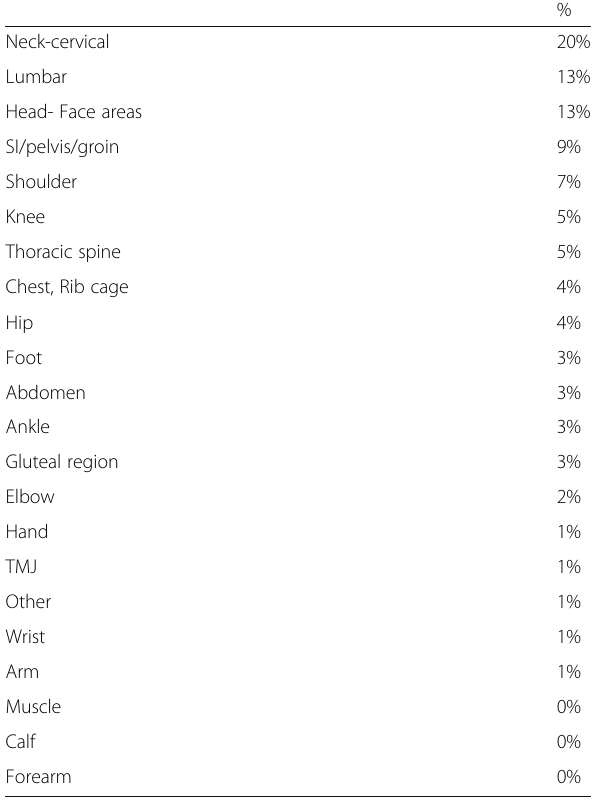
Table 2 Reason for consultation (clinical presentation location) n = 311